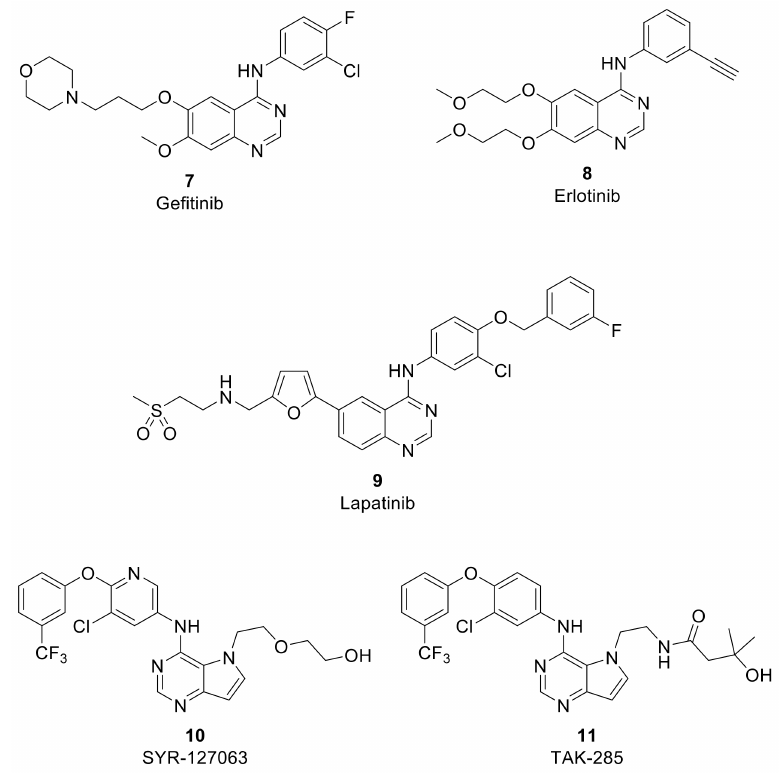
Figure 2. HER-2 TK